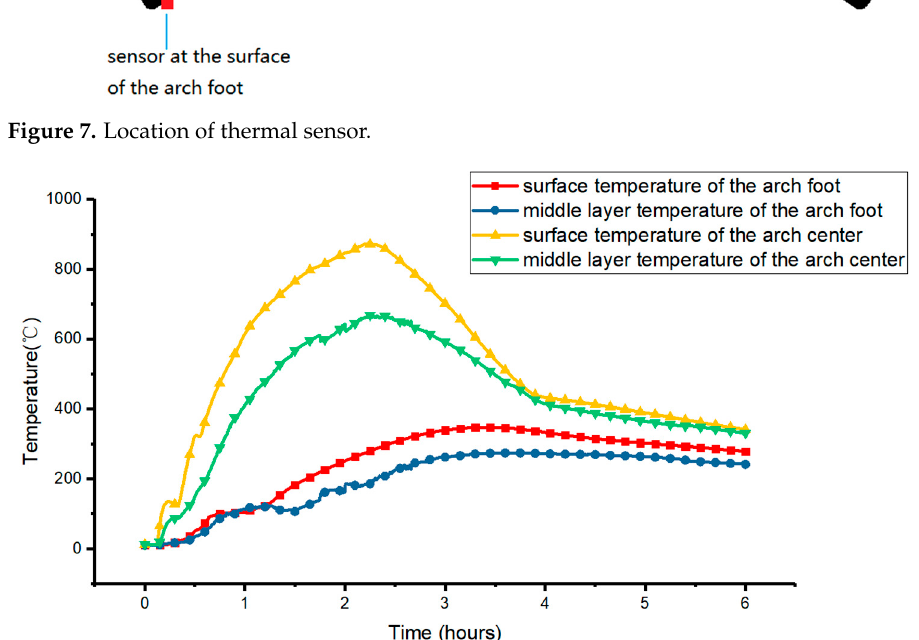
Figure 8. The surface and middle-layer temperatures of the center and foot of the concrete arch.